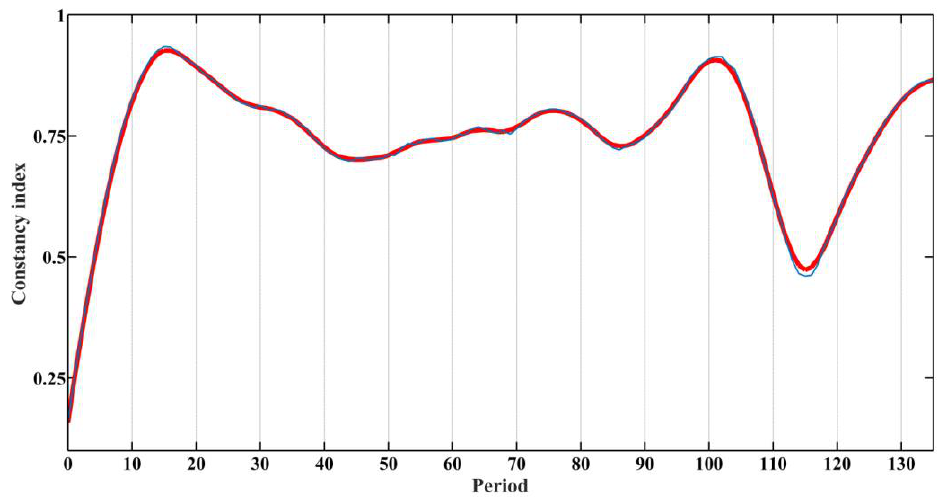
Figure 4. Function constancy exponent (construction—variance) and determination of periods.